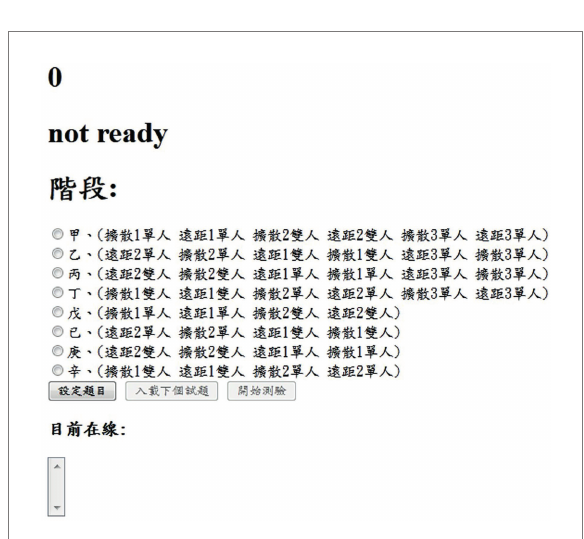
FIGURE 3 The administration page of the interactive creativity task